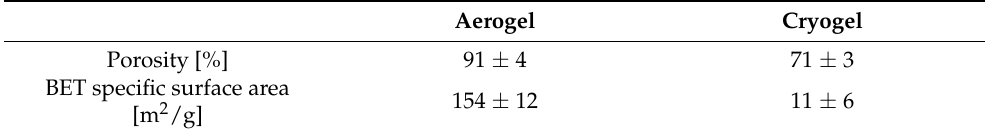
Table 4. Porosity and surface area values of 3% w/w agarose cryo/aerogels. Aerogel Cryogel Porosity [%] 91 ± 4 71 ± 3 BET specific surface area 154 ± 12 11 ± [m 2 /g]